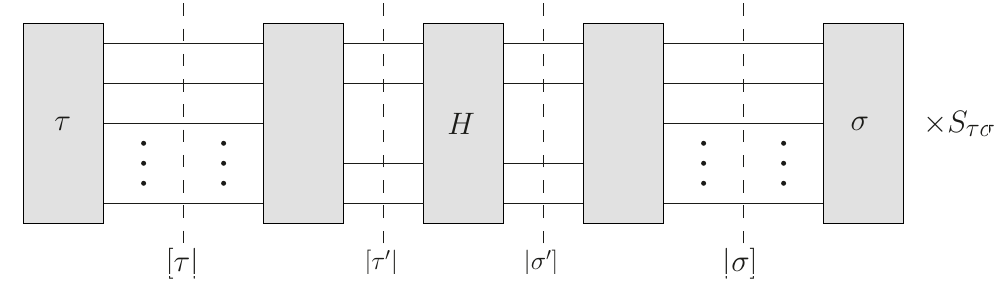
Figure 5 . The general structure of the calculation of subleading contributions.